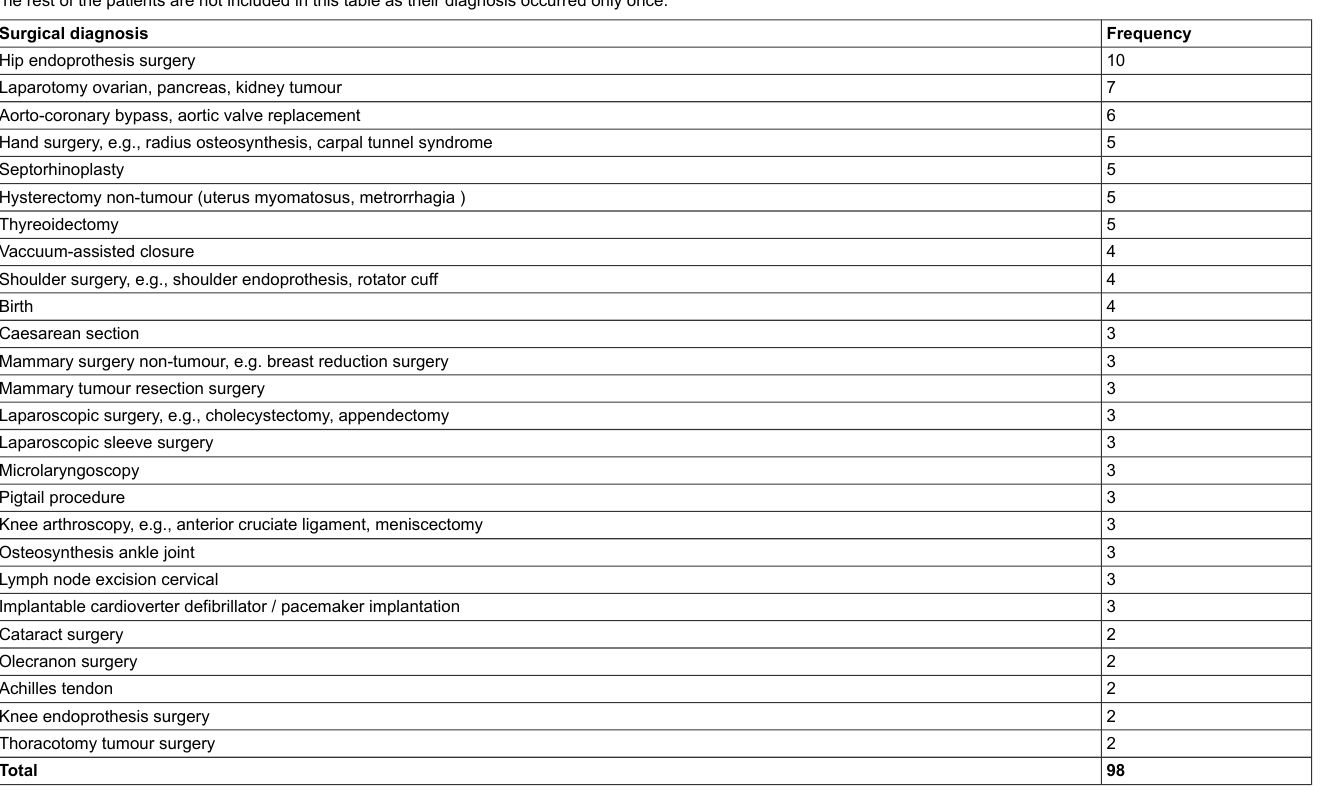
Table 2: Summary and description of complications leading to a report classified by the severity injury scale (n = 133). Dental damage cannot be classified by SIS and is therefore la- belled as N/A. SIS ≤4: temporary; SIS >4; permanent; SIS = 9: death Complication leading to a re-